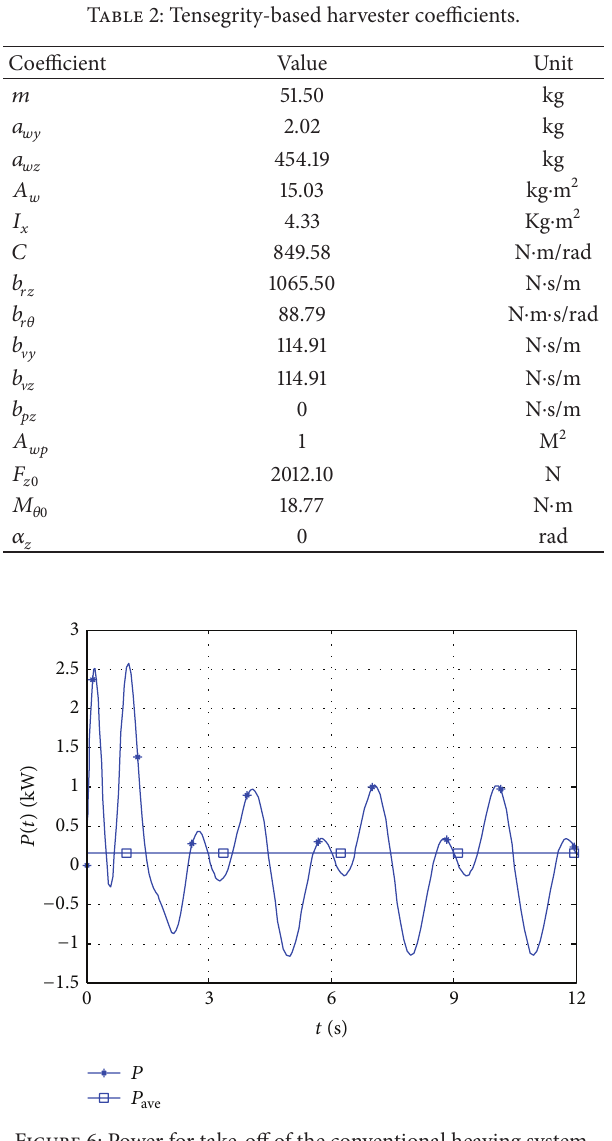
Figure 6: Power for take-off of the conventional heaving system.